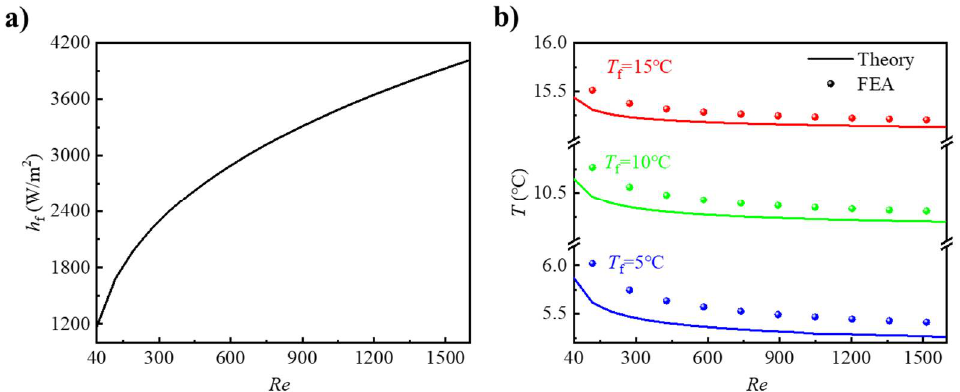
Figure 5. ( a ) Convective coefficient of the fluid–solid interface as a function of flow velocity. ( b ) The temperature at ( R c , 0) as a function of flow velocity.